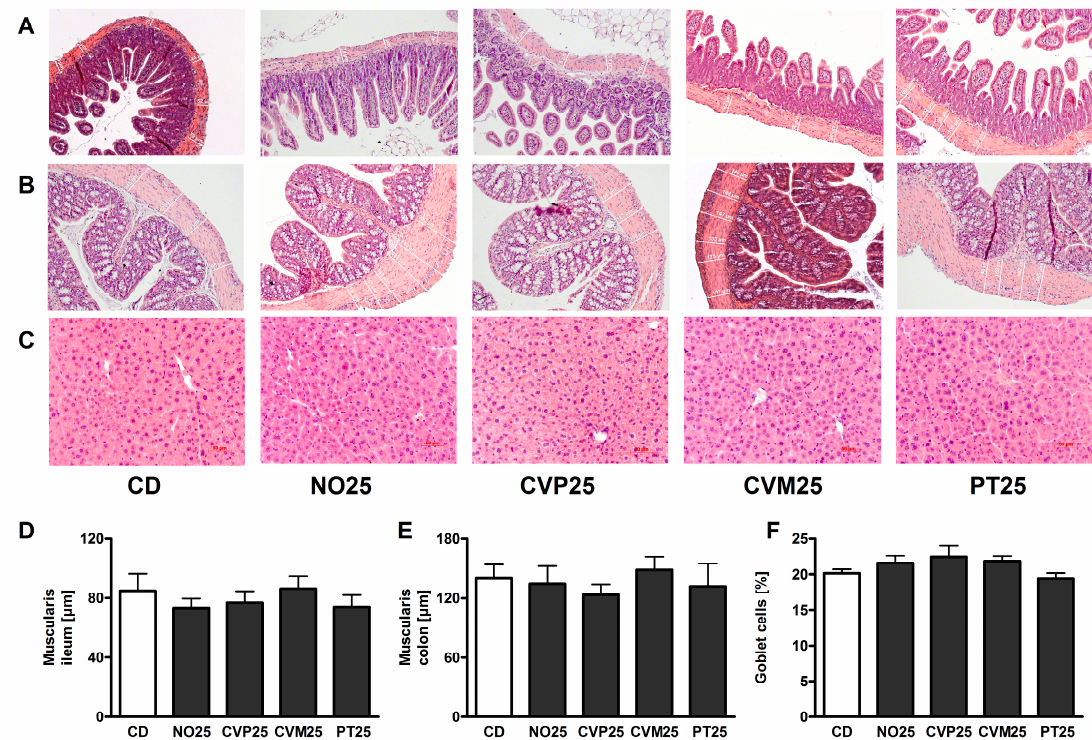
Figure 4. H&E stainings in C57BL/6 mice after 14 days supplementation of 25% (wt %) microalgae. Representative photomicrographs showing stainings (200 × magnification) of ileum ( A ) and colon ( B ) as well as stainings of liver tissue ( C ). Thickness of muscularis in ileum ( D ) and colon ( E ) and percentage of goblet cell area in colon ( F ) of C57BL/6 mice after 14 days on control diet (CD) or microalgae supplementation ( N. oceanica (NO), C. vulgaris phototrophic cultured (CVP), C. vulgaris mixotrophic cultured (CVM), P. tricornutum (PT)). Measurements were conducted in hematoxylin-eosin stained tissue samples. Data are expressed as means ± SEM ( n = 5–6, no significant differences analyzed by ANOVA.